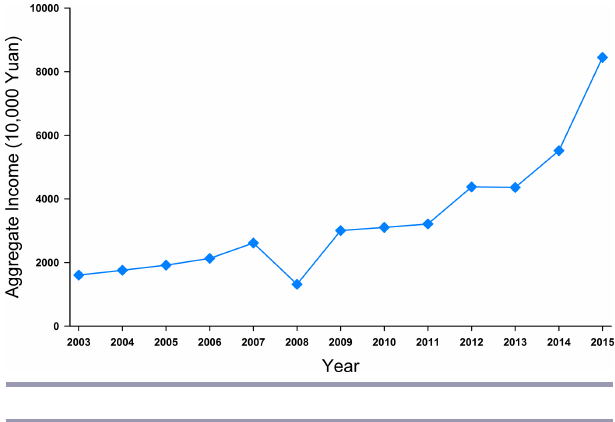
Fig. 4 . Average household income change in Wolong from 2003 to 2015 (based on data from the Wolong Administration